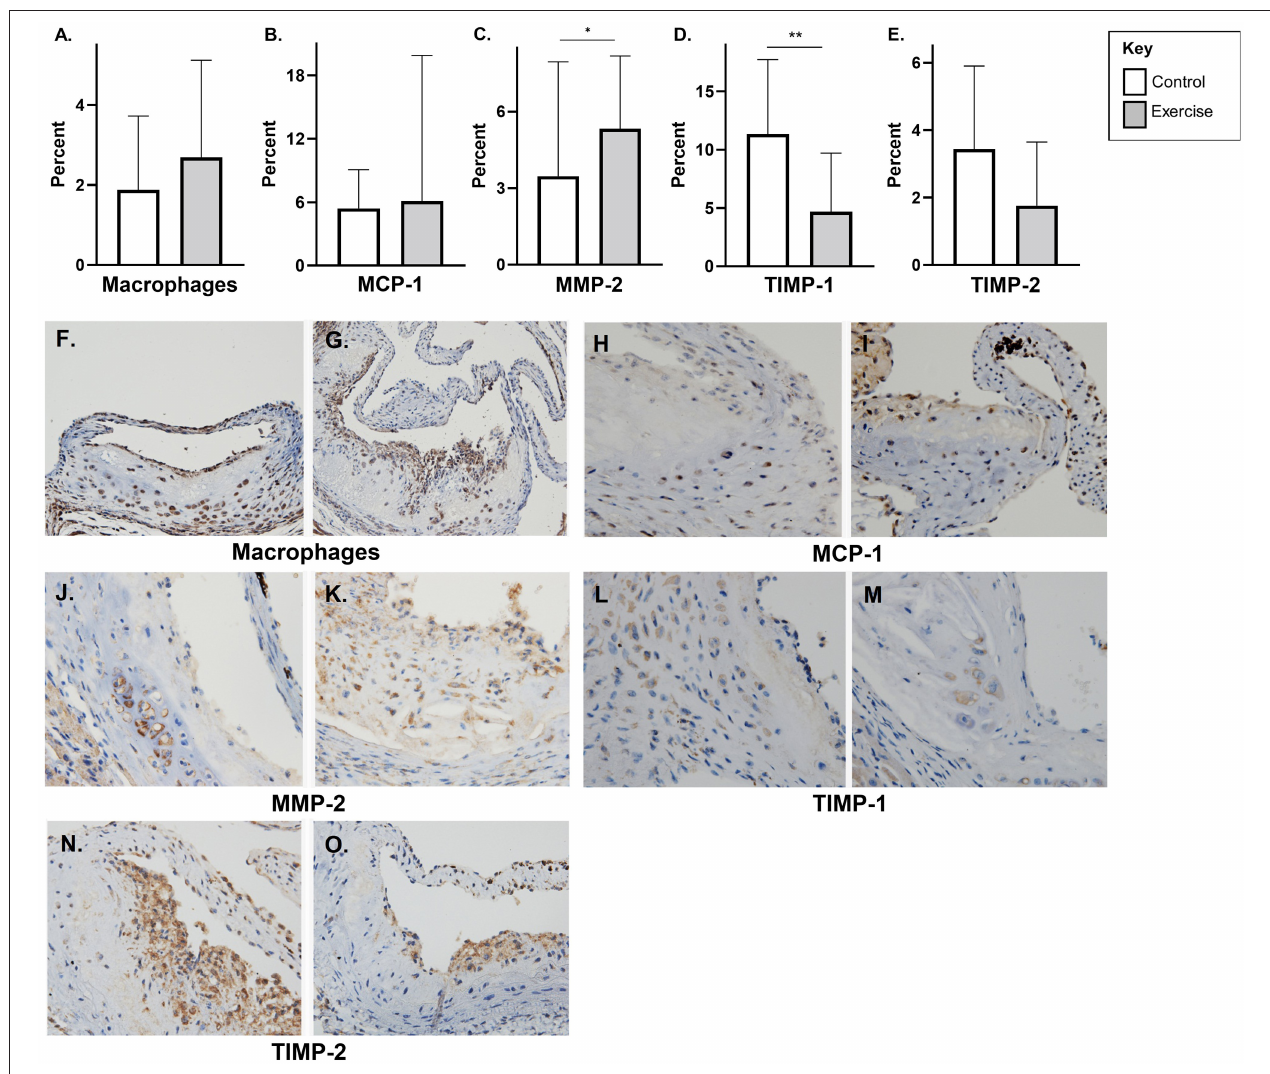
FIGURE 3 | The effect of exercise on F4/80, MMP-2, TIMP, and MCP-1 levels in an early-stage model of atherosclerosis. Chow fed apoE -/- mice with early-stage plaques were exposed to exercise for 10 weeks at 12 weeks of age. Aortic sinus sections were assessed for plaque content of (A) macrophages (F4/80%), (B) monocyte chemoattractant protein-1 % (MCP-1) (C) matrix metalloproteinase-2 % (MMP-2), (D) tissue inhibitor of metalloproteinase-1 % (TIMP-1), and (E) tissue inhibitor of metalloproteinase-2 % (TIMP-2). Data are expressed as mean ± SD. The x -axis represents the control (white bar) vs. the exercise group (gray bar). Representative sections of the aortic sinus with stains for macrophage content (F4/80) [ (F) control, (G) exercise], MCP-1 [ (H) control, (I) exercise], MMP-2 [ (J) control, (K) exercise], TIMP-1 [ (L) control, (M) exercise], and TIMP-2 [ (N) control, (O) exercise], with magnification x 600. * p < 0.05 ** p < 0.01.